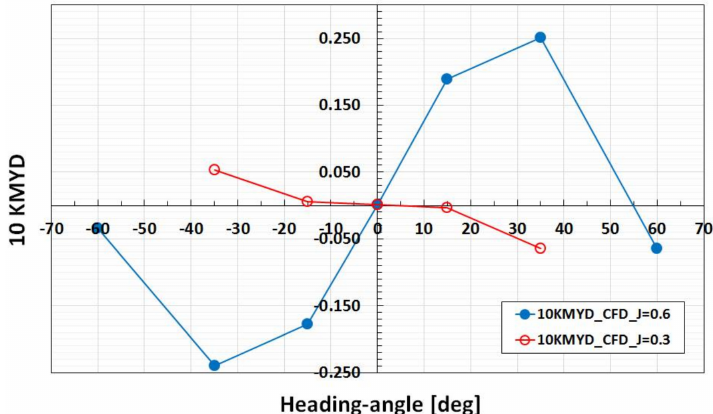
Figure 12. Computed steering moment on the duct, KMYD, at different heading angles and loading